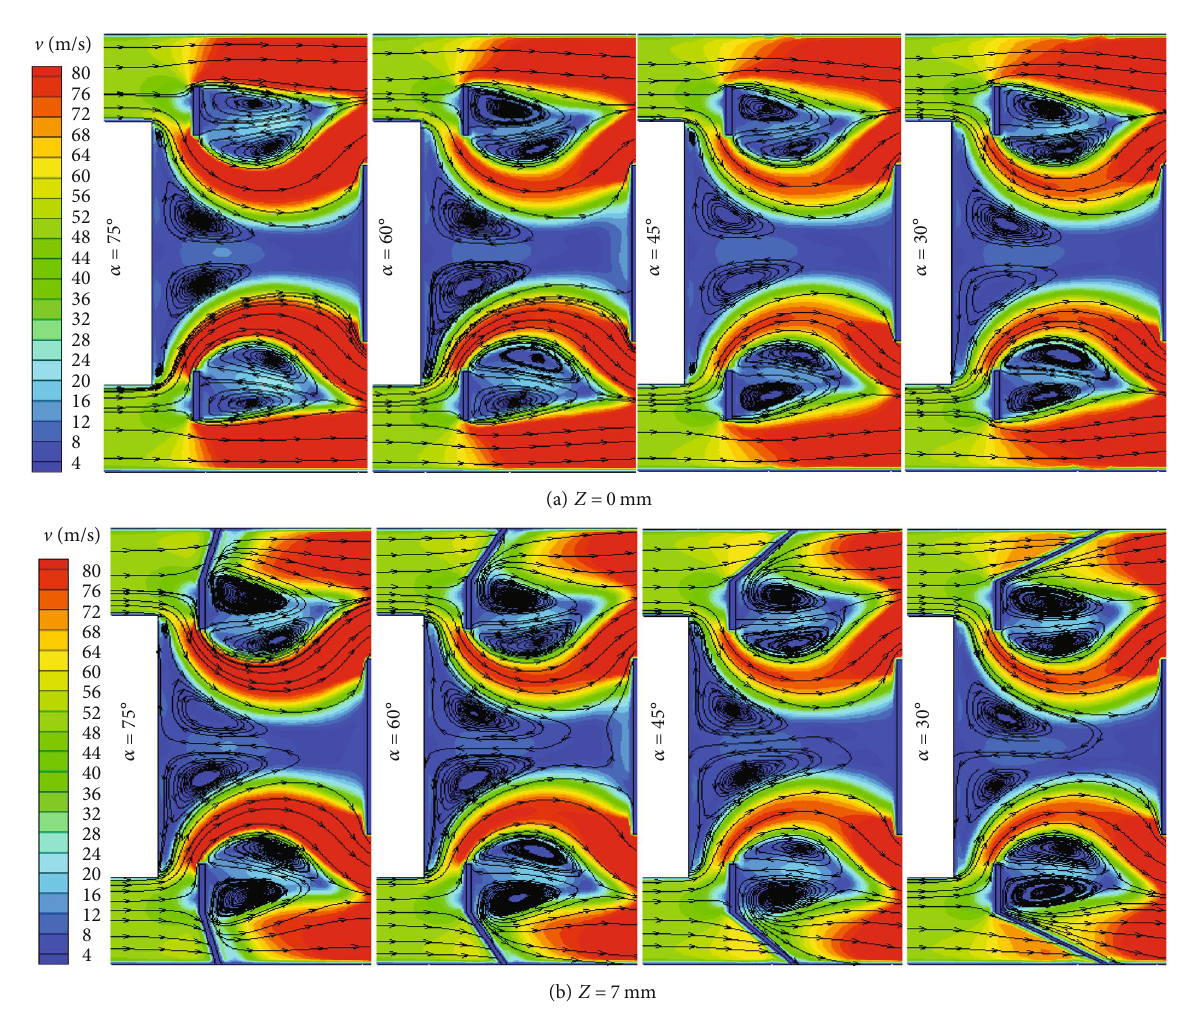
Figure 5: Velocity distribution in the cavity under di ff erent α